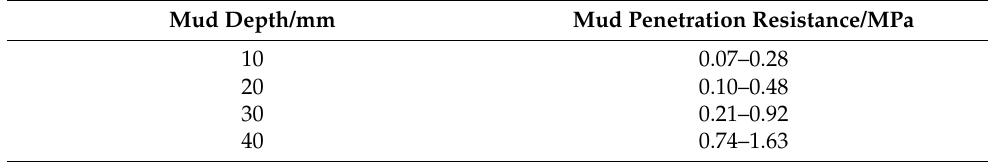
Table 1. Mud penetration resistance.